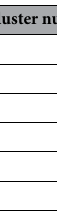
Table 1. P value of the corresponding survival difference under different cluster numbers.